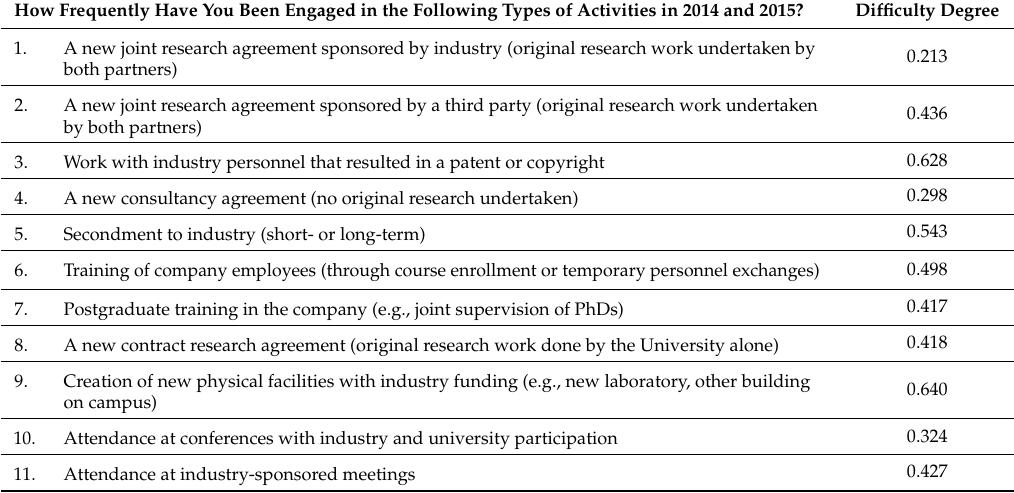
Table 1. Academic engagement activities and difficulty